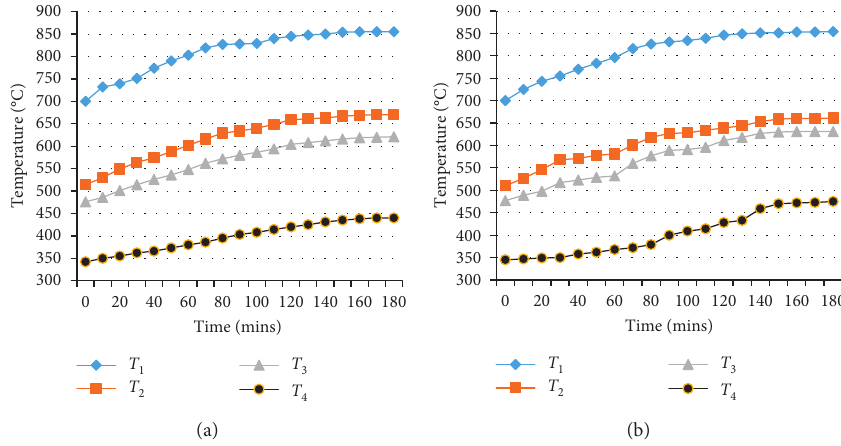
Figure 5: Plot of temp against time for (a) Mui and (b) Taru coal.